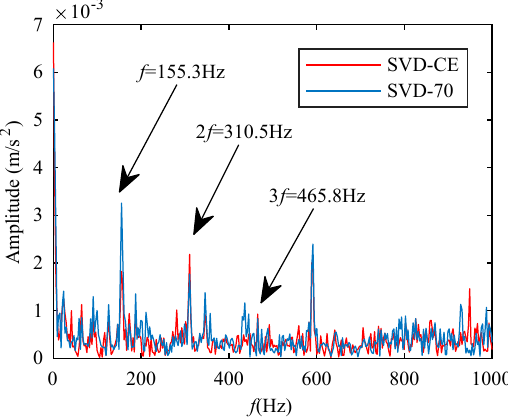
Figure 16. CCES of reconstructed signals at drive end with two method.